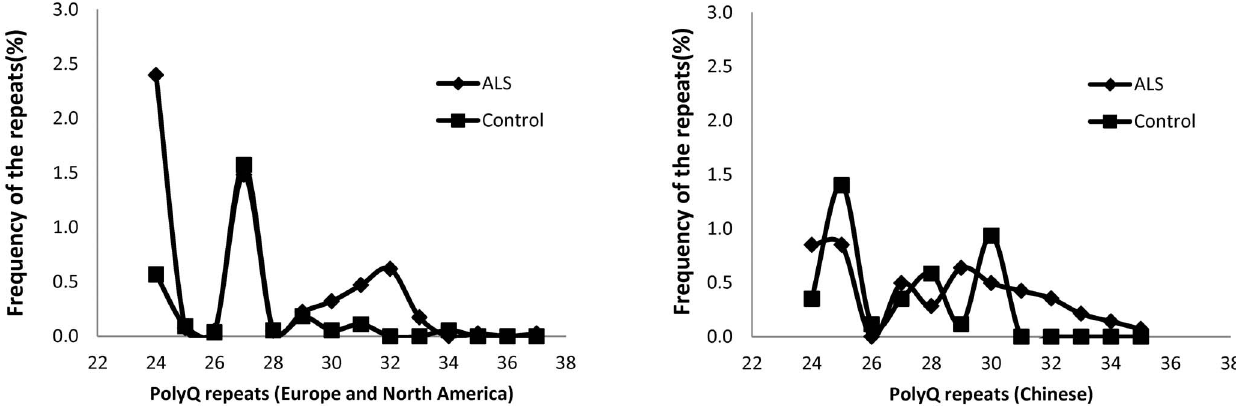
Figure 2. Identification of the differences of the presence of intermediate CAG repeats and potential ethnic variances in the ATXN2 gene among ALS and control subjects. The data about the number of CAG repeats in ALS and control subjects from 9 included studies in Caucacians and from 2 included studies from Chinese were summarized and plotted separately (left panel; right panel).